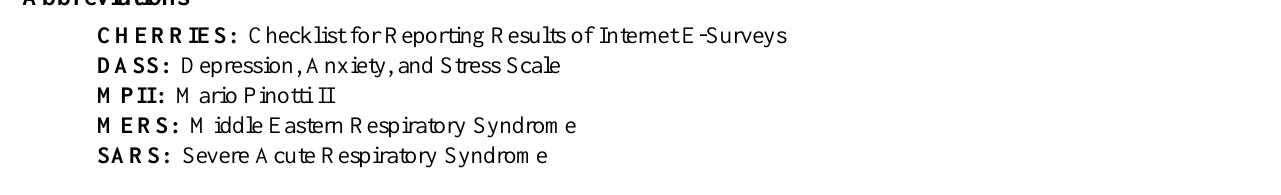
SARS: Severe Acute Respiratory